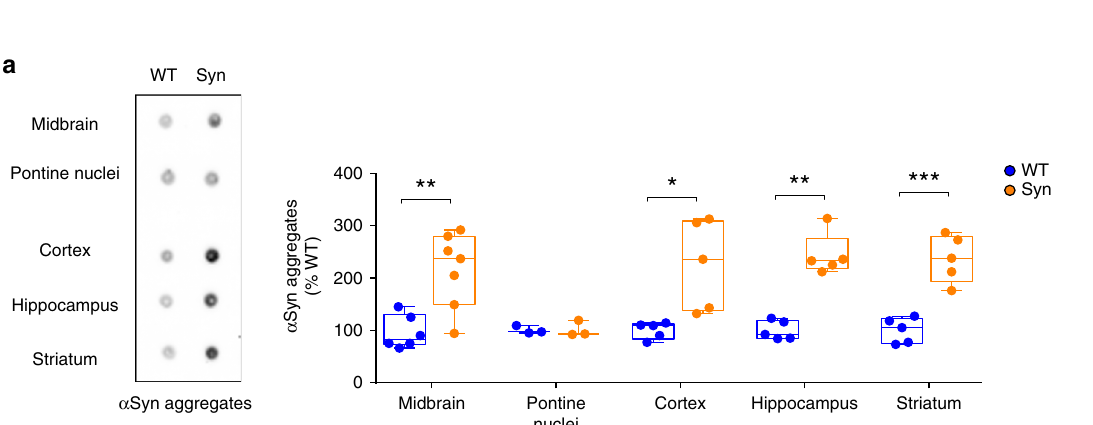
Fig. 5 Region-speci fi c aggregation of pathological α -syn in Syn rats. a Representative dot blot of midbrain, pontine nuclei, cortex, hippocampus and striatum homogenates from 4-month-old WT and Syn rats, immunostained with the conformation-speci fi c α -syn antibody [MJFR-14-6-4-2], and densitometric quanti fi cation. The plot shows the levels of α -syn aggregates (expressed as % of WT). (Midbrain: 6 WT rats and 7 Syn rats, Welch ’ s t -test ** P = 0.004; Pontine nuclei: 3 rats per genotype, Welch ’ s t -test P = 0.926; Cortex: 5 rats per genotype, Welch ’ s t -test * P = 0.030; Hippocampus: 5 rats per genotype, Mann – Whitney test ** P = 0.008; Striatum: 5 rats per genotype, Welch ’ s t -test *** P = 0.001). The full blot and raw data are provided as a Source Data fi